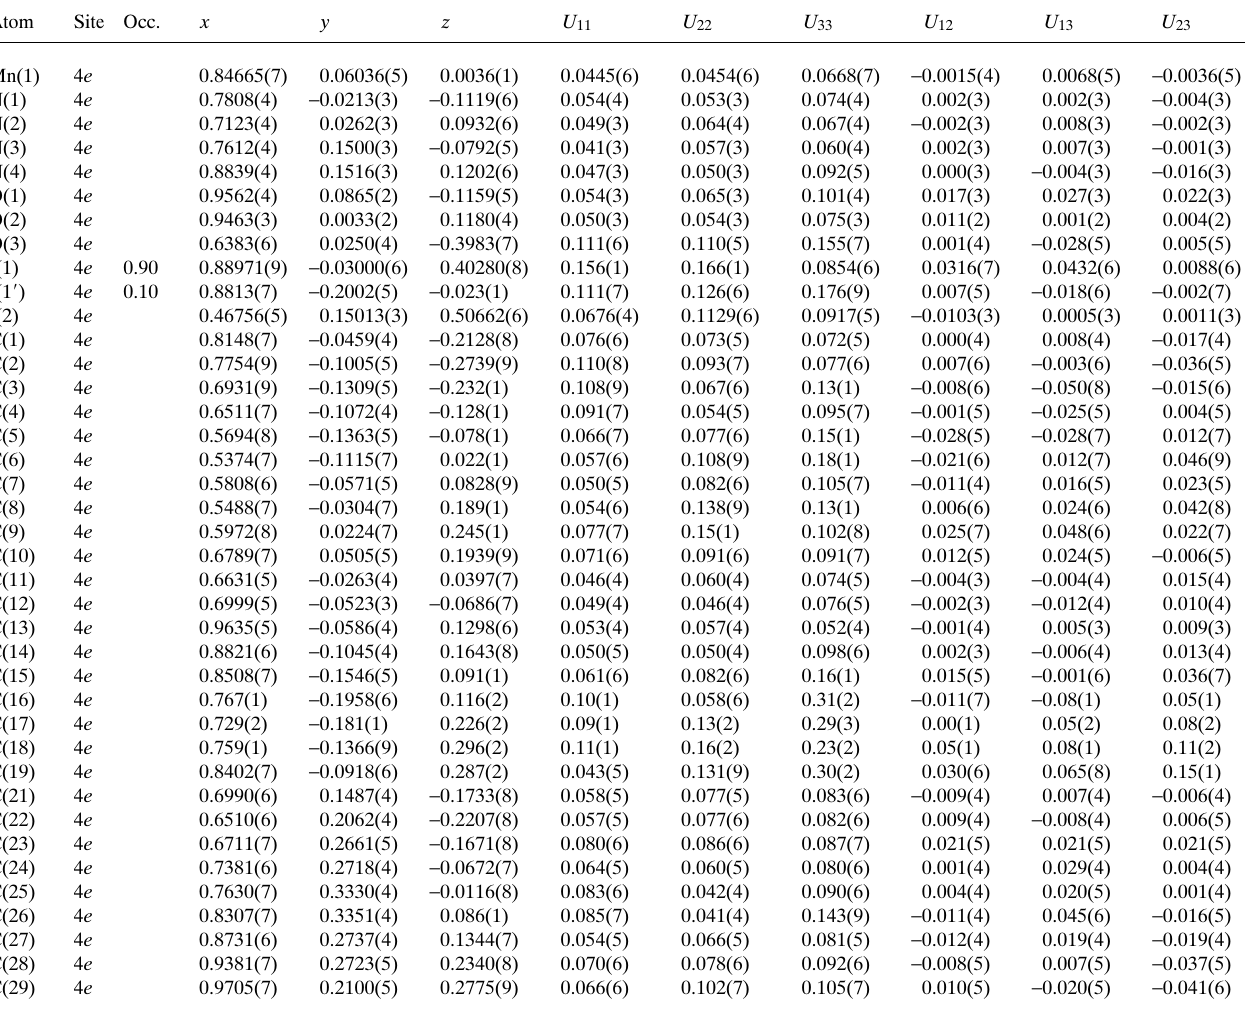
Table 3. Atomic coordinates and displacement parameters (in Å 2 ) .